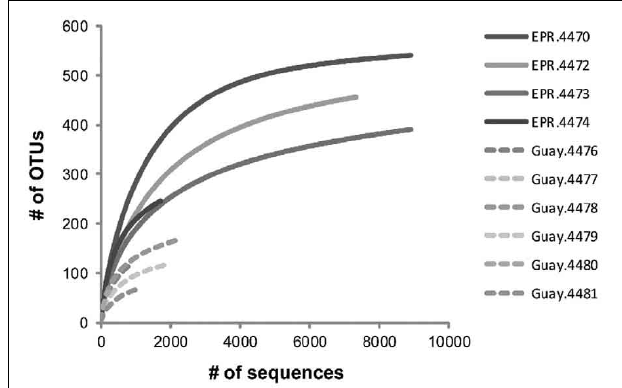
FIGURE 1 | Rarefaction analysis of vent-specific 16S rDNA amplicon sequences from diffuse flow samples collected at 9 ◦ N East Pacific Rise (EPR) and Guaymas Basin (Guay) hydrothermal vent sites.